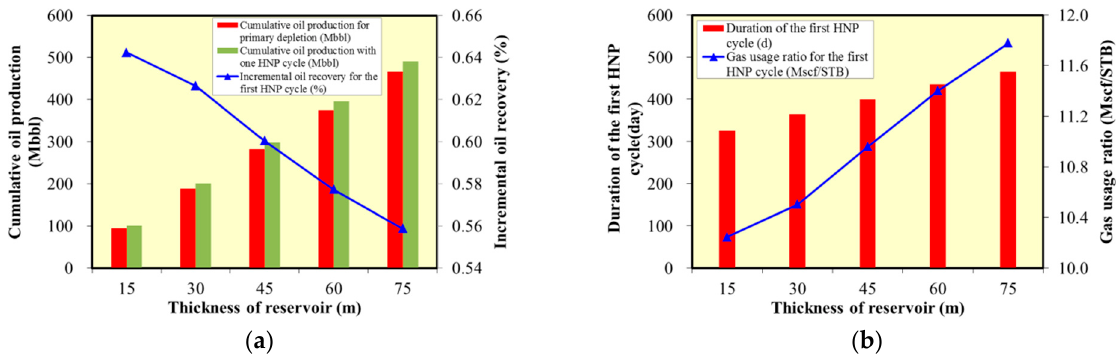
Figure 4. Effect of different reservoir thickness with one huff-n-puff cycle on oil production and reservoir pressure: ( a ) Cumulative oil production for different reservoir thickness; ( b ) Average reservoir pressure for different reservoir thickness.